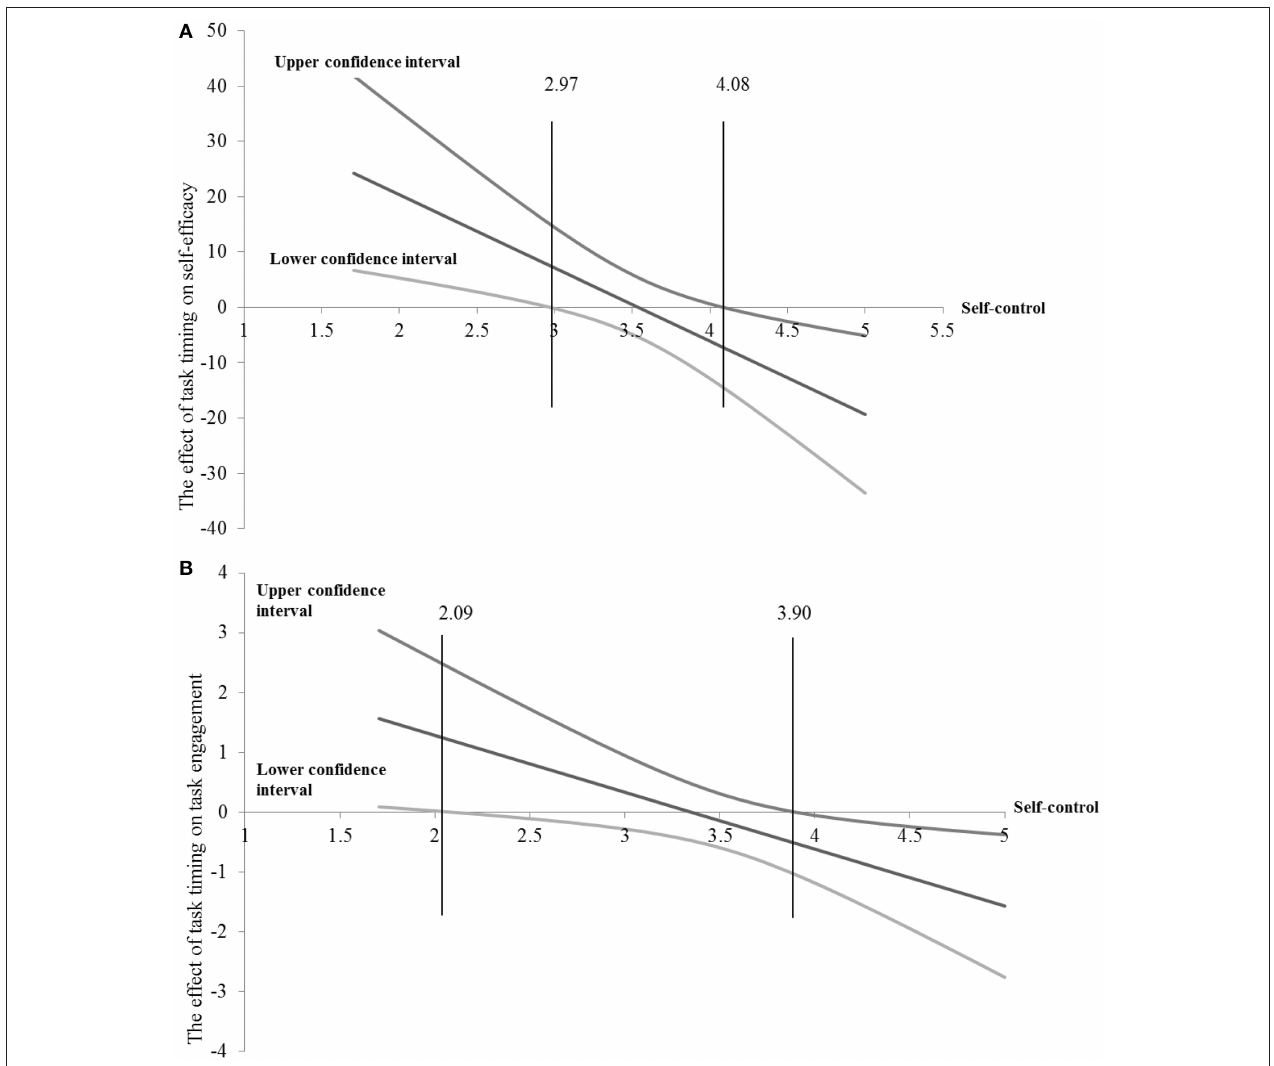
FIGURE 2 | (A) Effect of task timing on self-efficacy as a function of self-control levels. The graph was drawn on the basis of a floodlight analysis (Spiller et al., 2013; Disatnik and Steinhart, 2015), which examines the effect of task timing on self-efficacy for any value that self-control can take. Confidence bands are also presented, and the Johnson–Neyman points are obtained at self-control = 2.97 and self-control = 4.08 ( p = 0.05). (B) Effect of task timing on willingness to join a financial coaching program as a function of self-control levels. The graph is based on a floodlight analysis (Spiller et al., 2013; Disatnik and Steinhart, 2015), which examines the effect of task timing on willingness to join a financial coaching program for any value that self-control can take. Confidence bands are also presented, and the Johnson–Neyman points are obtained at self-control = 2.09 and self-control = 3.90 ( p =